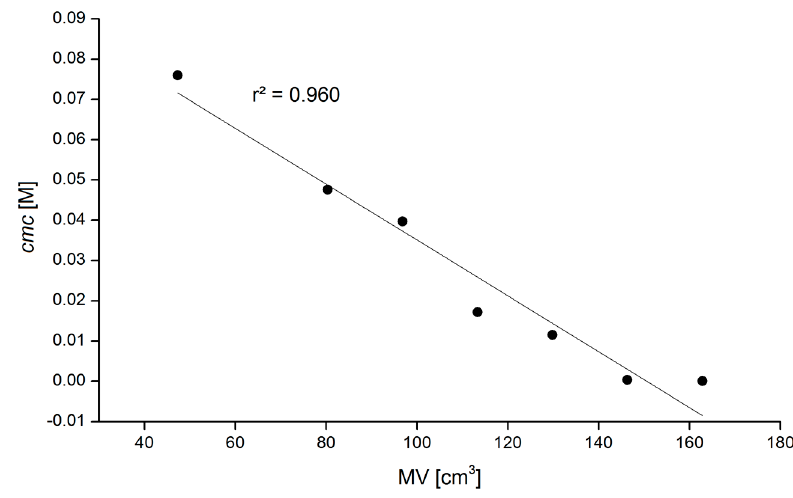
Figure 7. Dependence of cmc values on bulkiness alkoxy tail expressed as molar volume (MV [cm 3 ]) of substituent R.